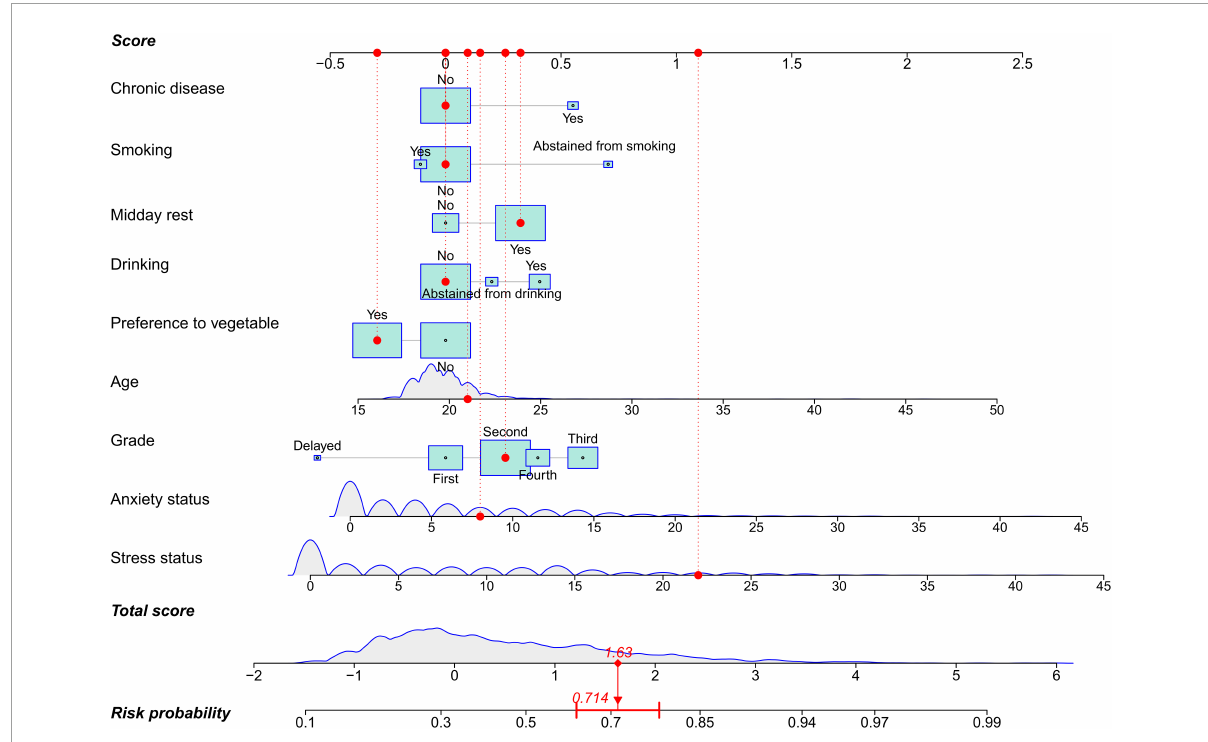
FIGURE2 A nomogram to predict sleep quality among university students. The nomogram is comprised of nine features and three axes (score, total score, and risk probability axes). Each feature is able to obtain a score by referring to the score axis, the total score is the sum points of the nine features, and participant’s risk probability can be calculated by drawing a line downward from the total score axis to the risk probability axis. In the nomogram, quantitative features are depicted as density curves to visualize distribution, and qualitative features including age, anxiety, and stress are presented as boxes. The size of boxes indicates proportions in each